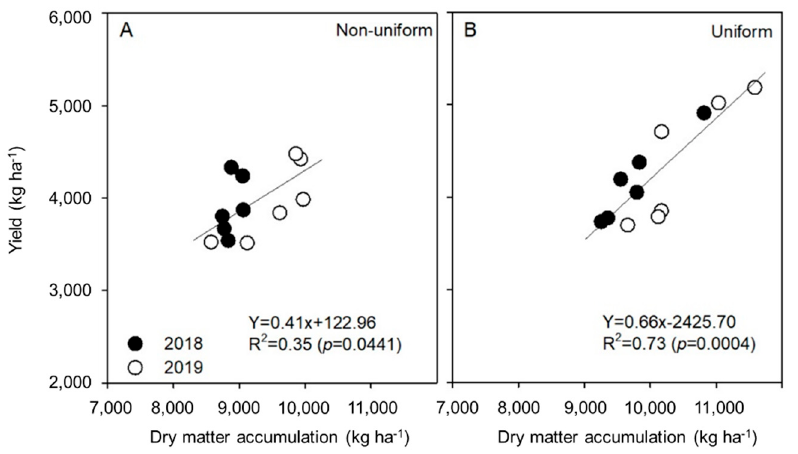
Figure 10. The relationship between yield and dry matter accumulation at maturity of the soybean under different plant distributions. ( A , B ) Non-uniform and uniform, respectively.